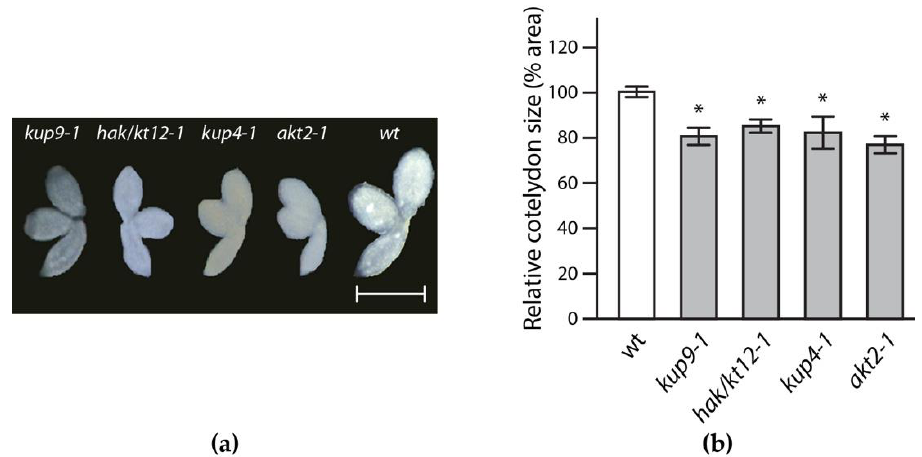
Figure 2. Microscopic analysis of T-DNA insertion mutants. ( a ) Differences in embryo phenotypes of selected T-DNA insertion lines compared to wild-type Arabidopsis (wt). Scale bar, 500 µm; ( b ) Quantitative analysis of cotyledon area. Error bars represent the standard error of the mean of three independent experiments, n = 12 (Student’s t -test; * p < 0.05).